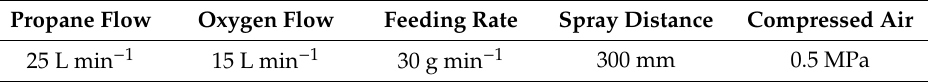
Table 1. Atmospheric plasma (APS) spraying parameters.